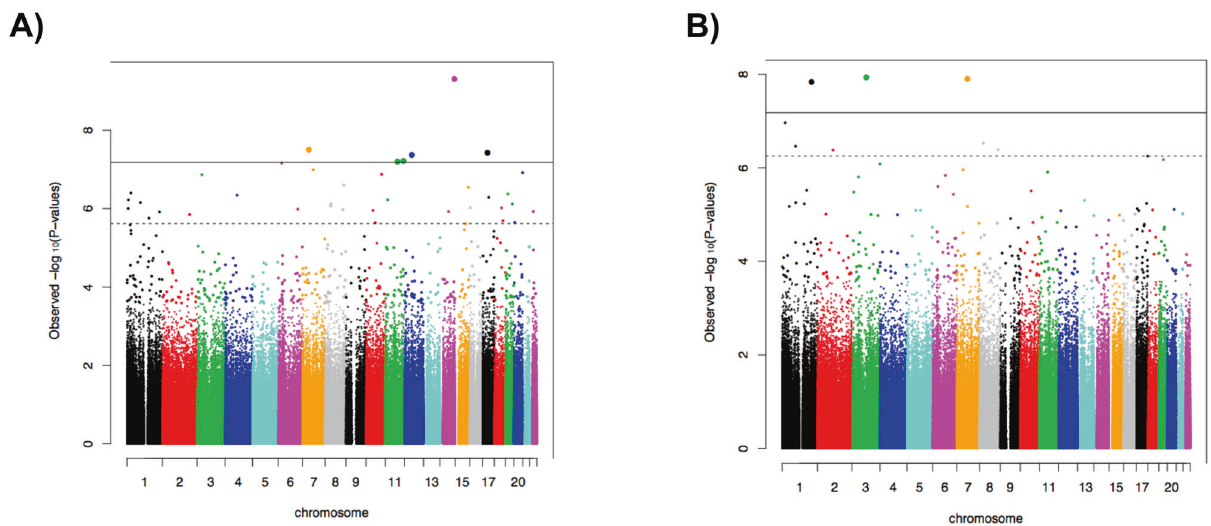
Fig. 1 Manhattan plots of the association between DNA methylation and PTSD. A Current PTSD, B Lifetime PTSD. The horizontal solid line represents Bonferroni-corrected signi fi cance. The dotted line indicates false discovery rate of <